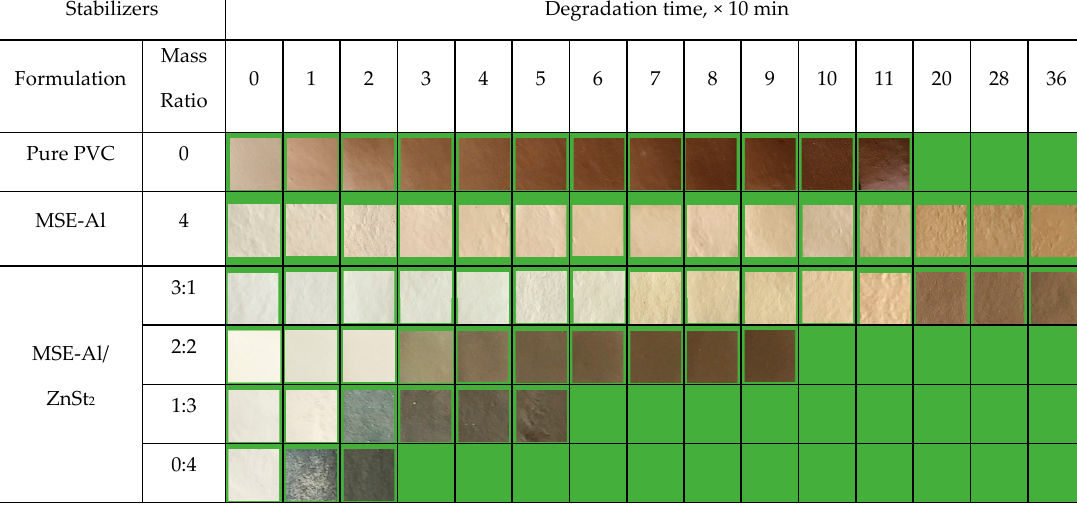
Figure 9 is the torque rheometer curves of pure PVC and PVC samples stabilized by 4 phr of different thermal stabilizers. In the rheological curve (Figure 9), point A is the filler torque peak, and the greater the torque, the greater the friction of PVC mixture just entering the mixing chamber of the torque rheometer. Point B is the plasticizing torque peak, and its corresponding time indicates the plasticizing effect and difficulty of the PVC mixture. Point C is the balance torque and represents the processing performance (lubricating property) of the PVC mixture. Figure 9 shows that the filler torque values and balance torque values of the PVC samples stabilized by MSE-Al and ZnSt 2 are much lower than that of pure PVC. It was worth noting that the PVC sample stabilized by 4 phr of ZnSt 2 had the lowest balance torque, showing that ZnSt 2 had the best lubricity for PVC. The balance torque of the PVC sample stablized by 4 phr of MSE-Al was much lower than that of pure PVC. All of the results showed that MSE-Al and ZnSt 2 had good lubrication. This might be due to the presence of a stearic acid radical functional group in MSE-Al and ZnSt 2 , which gave MSE-Al and ZnSt 2 good lubricity.